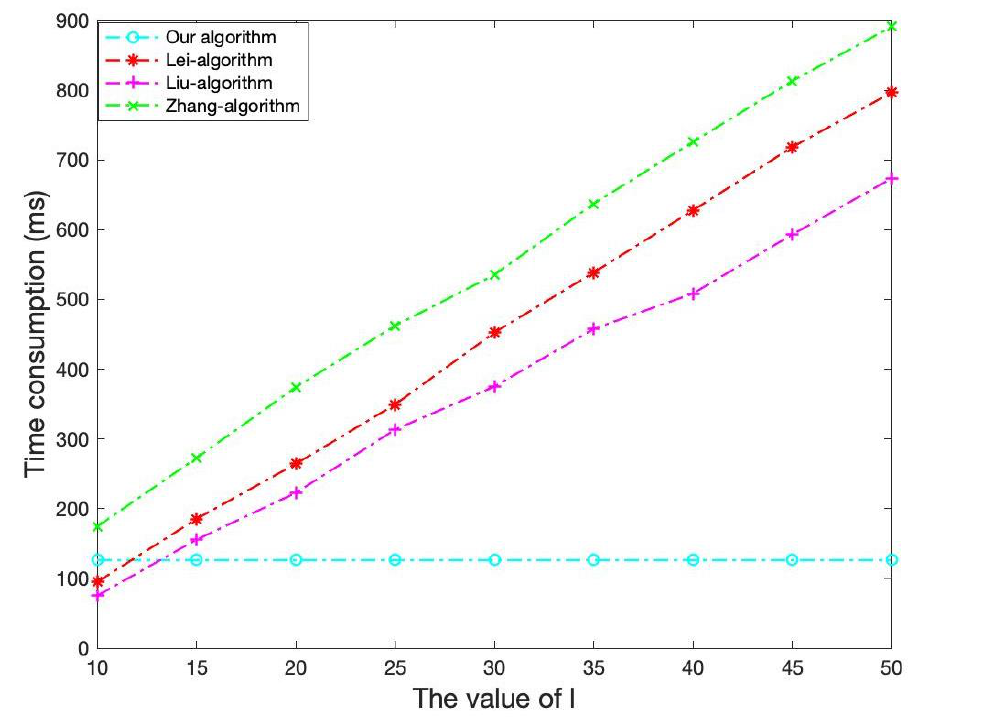
Figure 5. The time consumption of the client when using different parameter l .